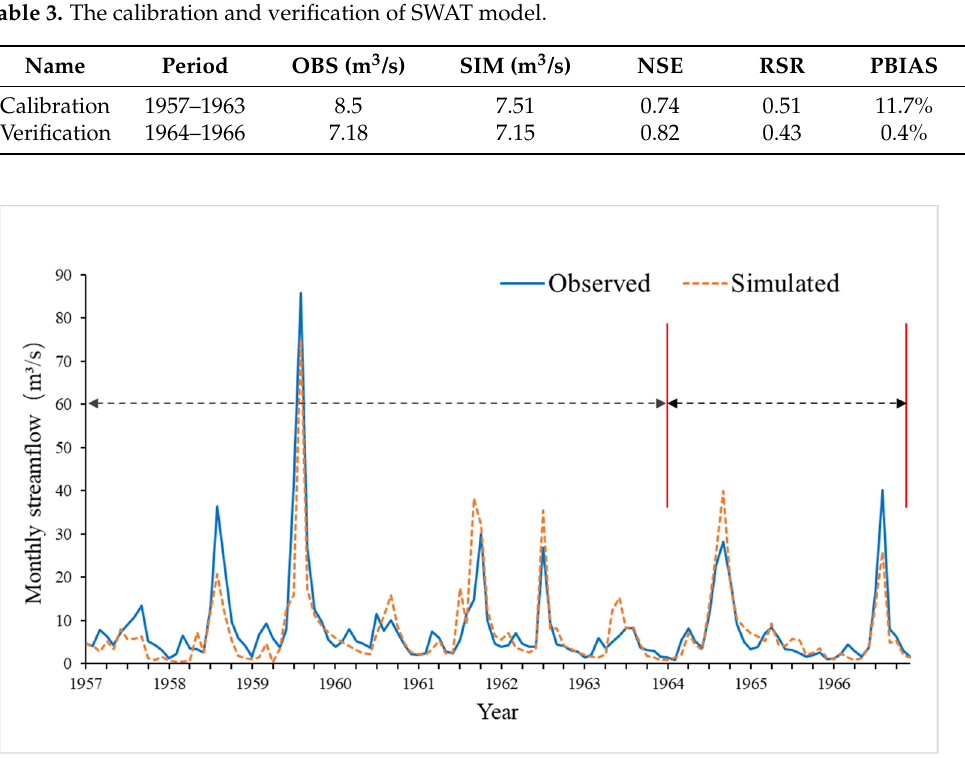
Figure 5. Observed and simulated using the SWAT model annual runoff series during the period of 1967--2017. 3.2. Constructing the DMC The double mass curve of the accumulated rainfall and the accumulated runoff depth ( ∑ (cid:1844) versus ∑ (cid:1842) ) was constructed for 1952–2017 (Figure 6). If the human activities’ impact on the runoff is constant or negligible, the plot of these two cumulative variables (precip- itation and runoff) is a straight line. A significant change in the slope of the DMC indicates changes due to the contributions of the human activities. The one-variable linear regres- sion equations of the DMCs for the four different periods were calculated. The slope of the linear relationship between the cumulative runoff and the cumulative precipitation was 0.1937 in the base period, 0.1619 in the first affected period (1967–1987), 0.1163 in the second affected period (1988–1994), and 0.1072 in the third affected period (1995–2017). The slopes of the four different periods exhibit a decreasing trend, indicating that the in- terferences of the coal mining and soil-water conservation measures on the runoff in- creased.